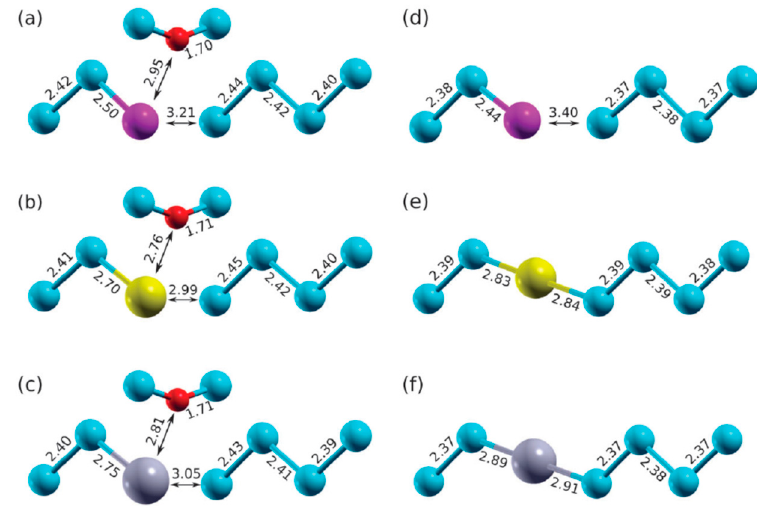
Figure 14. The isovalent dopant—VO interactions along the (10-1) direction: ( a ) GeVO, ( b ) SnVO, ( c ) PbVO, ( d ) GeV, ( e ) SnV, and ( f ) PbV. Larger spheres represent the isovalent dopant, blue spheres the Si atoms, and red spheres the O i atoms. All the distances are in Å. Reprinted with permission from the PCCP Owner Societies, [123].